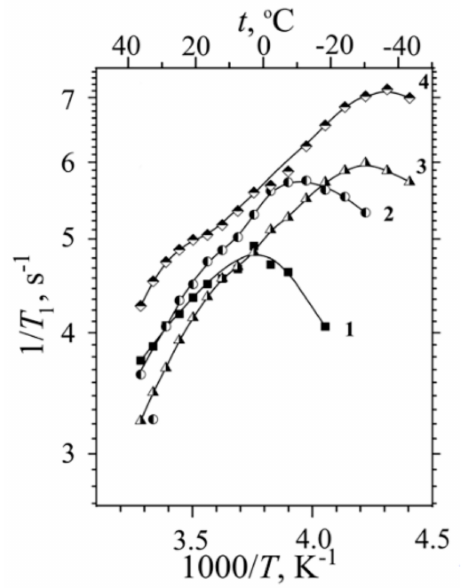
Figure 21. Temperature dependences of 1 H spin–lattice R 1 ( T 1 − 1 ) relaxation rates in Nafion 117 mem- brane with different water content (1) λ = 3.2; (2) λ = 4.4; (3) λ = 5.8; (4) λ = 7.4. Reprinted with permission from [25]. Copyright 2019 Springer